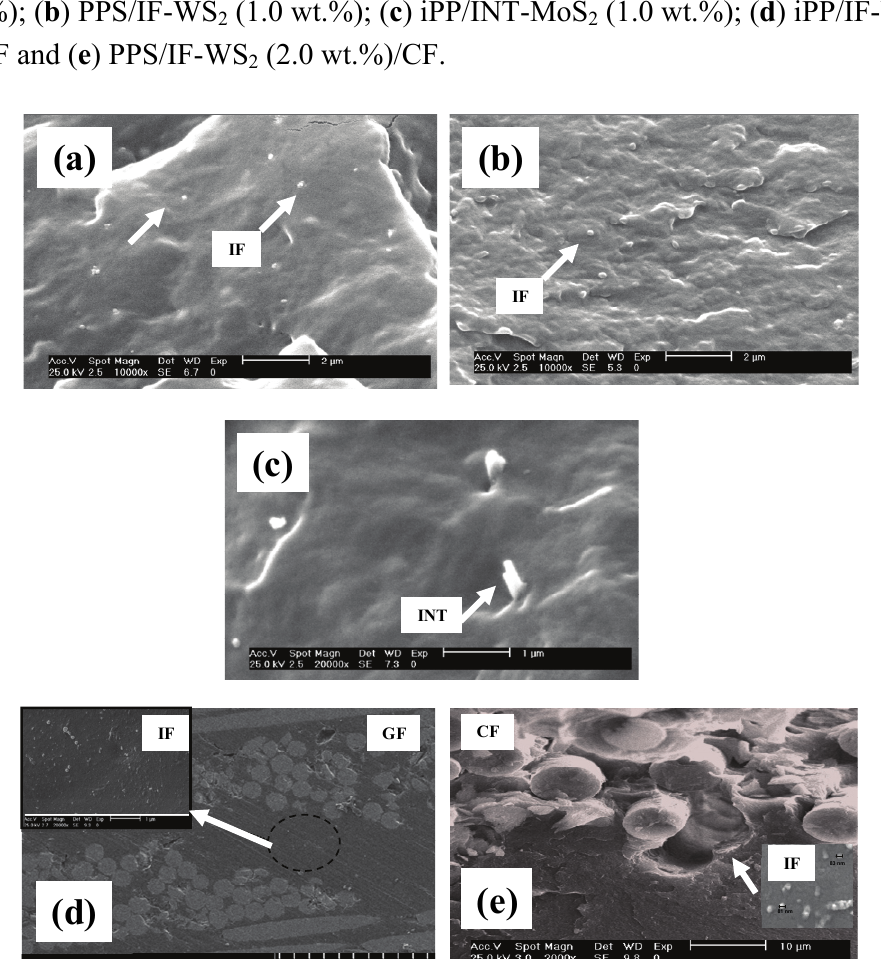
Figure 1. SEM micrographs of novel polymer/IF(INT) nanocomposites. ( a ) iPP/IF-WS (1.0 wt.%); ( b ) PPS/IF-WS